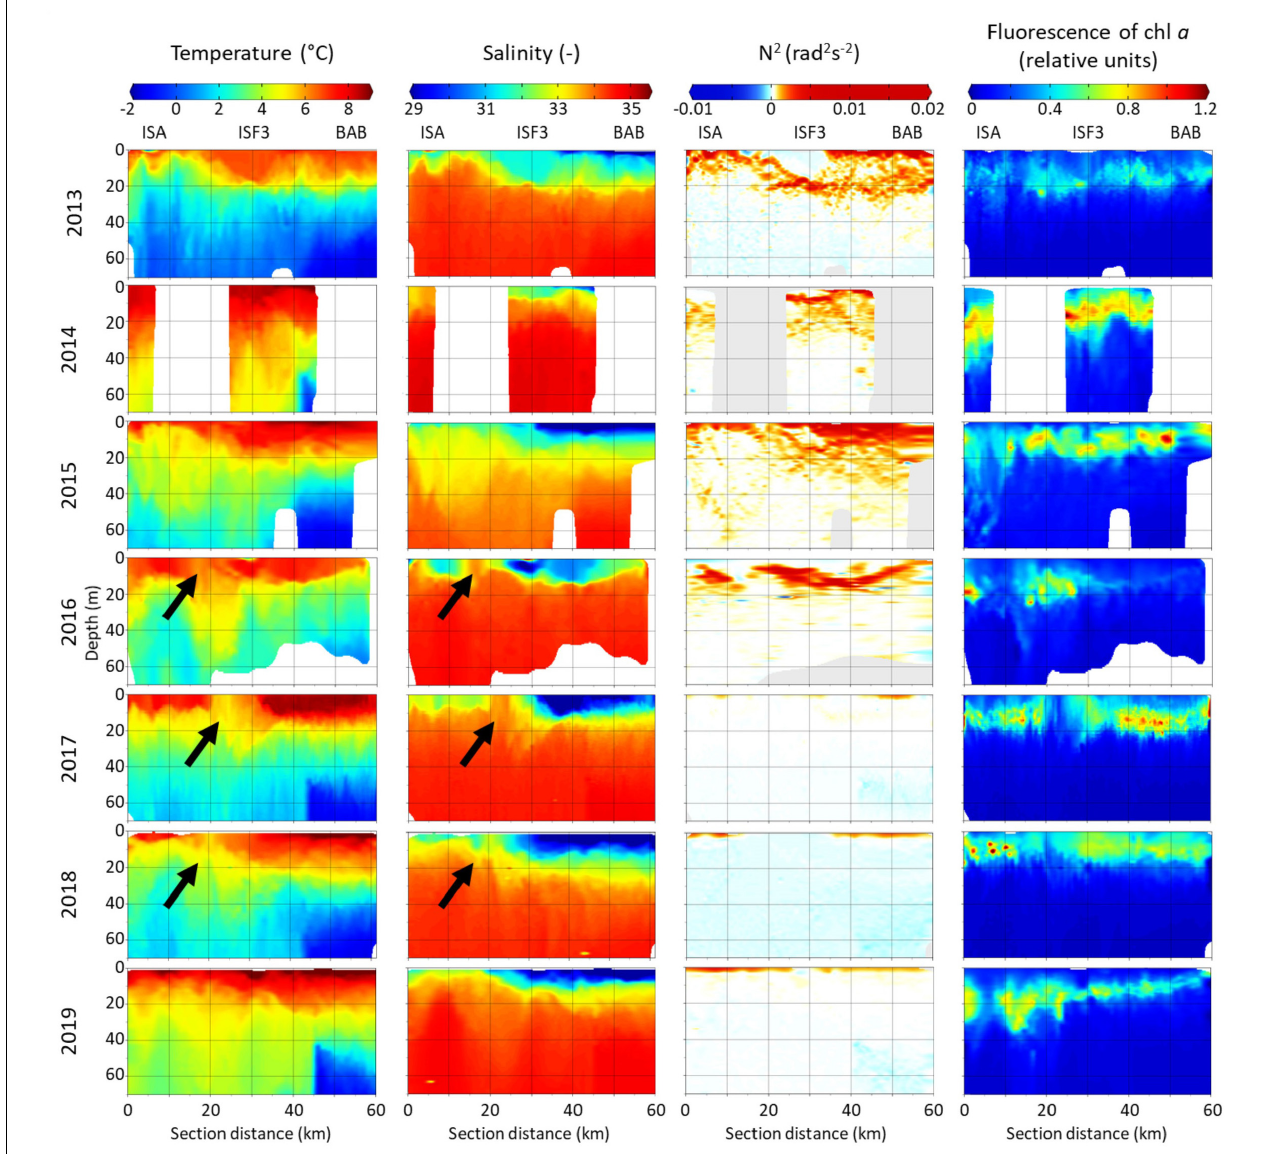
FIGURE 2 | Distribution of temperature ( ◦ C), salinity, water column stability (Brunt–Väisälä frequency squared N 2 [rad 2 s − 2 ]) and fluorescence of chlorophyll a (relative units) along Isfjorden transect from ISA station (left side of each graph) up to BAB station (right side of each graph) in seven consecutive mid-summers (2013–2019). Arrows indicate a hydrographical discontinuity followed by